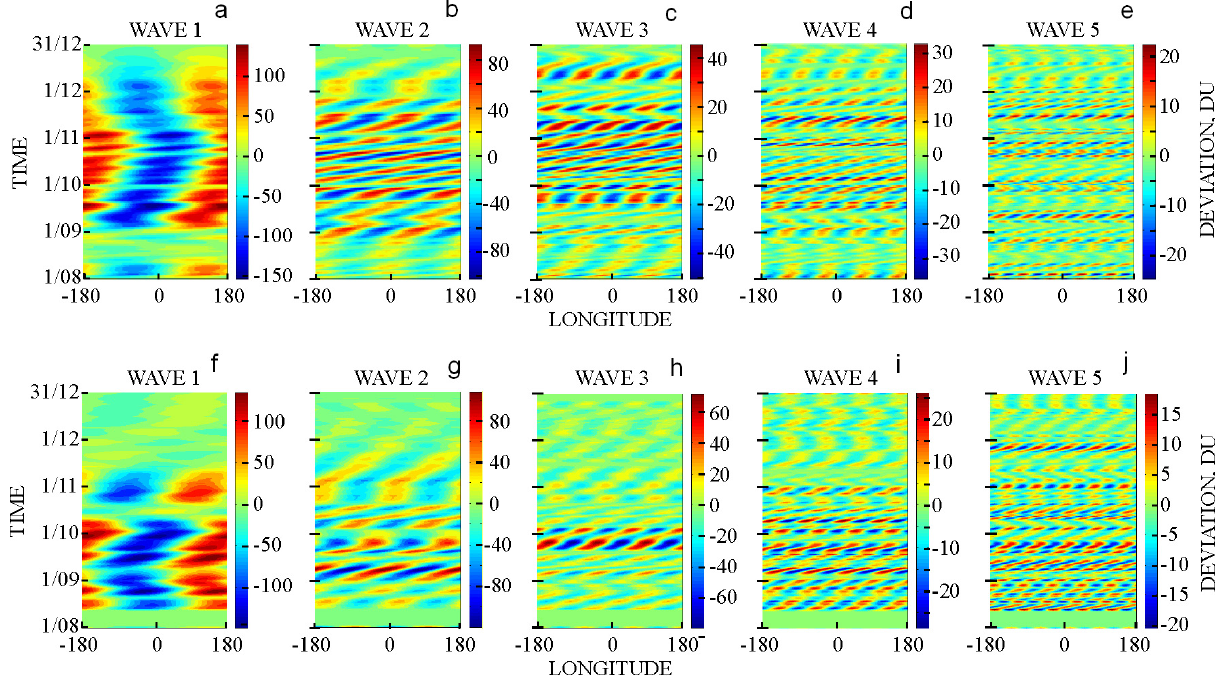
Fig. 2. Time-longitude variations of the daily deviation from the zonal mean at 65 ◦ S for the wave numbers 1–5 during August-December 1996 (a-e) and 2002 (f-j) .